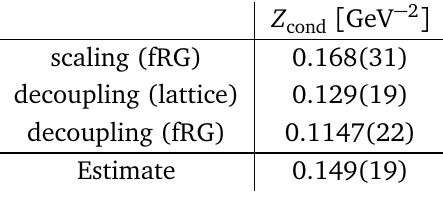
Table 1: Extrapolation results for the wave function renormalisation Z ( p ) as a function of the lower fit interval bound based on the fit results for Z cond min p , see Figure 8. The final estimate is obtained as the average of the scaling fRG min and decoupling lattice data. In order to conservatively estimate possible systematic uncertainties (see text), we use the separate scaling fRG and lattice results as error